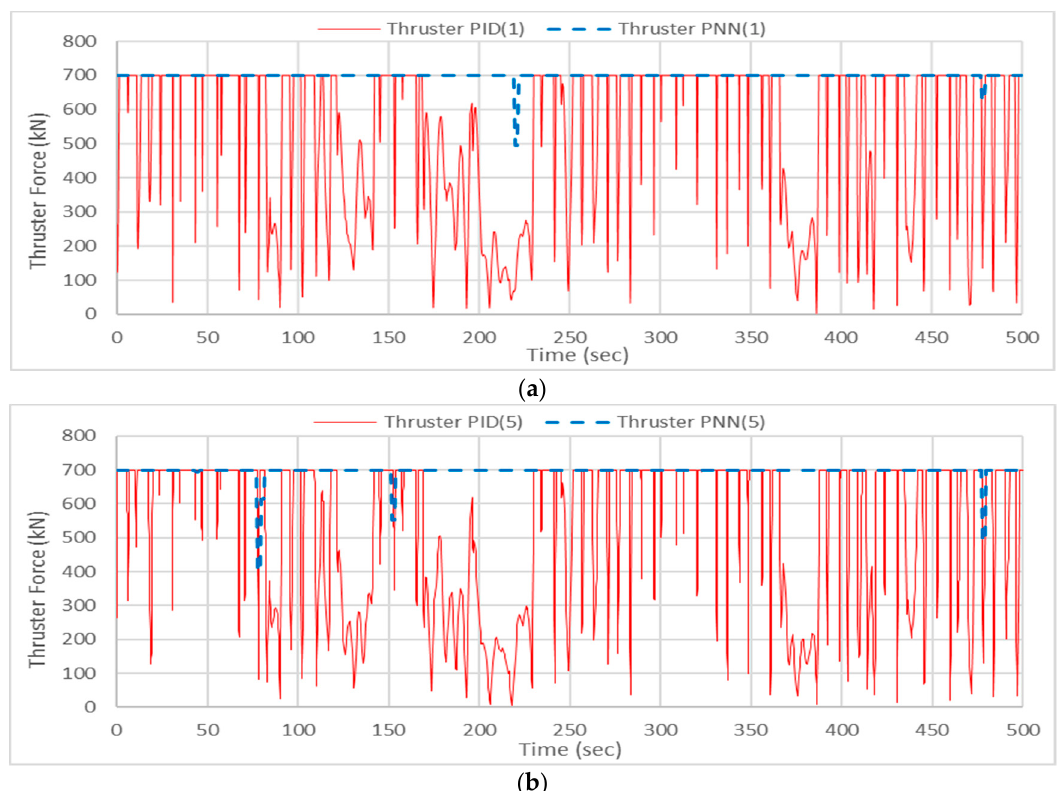
Figure 17. DP simulation with PID and PNN controls showing thruster force (Head sea): ( a ) Thruster 1; ( b ) Thruster 5.